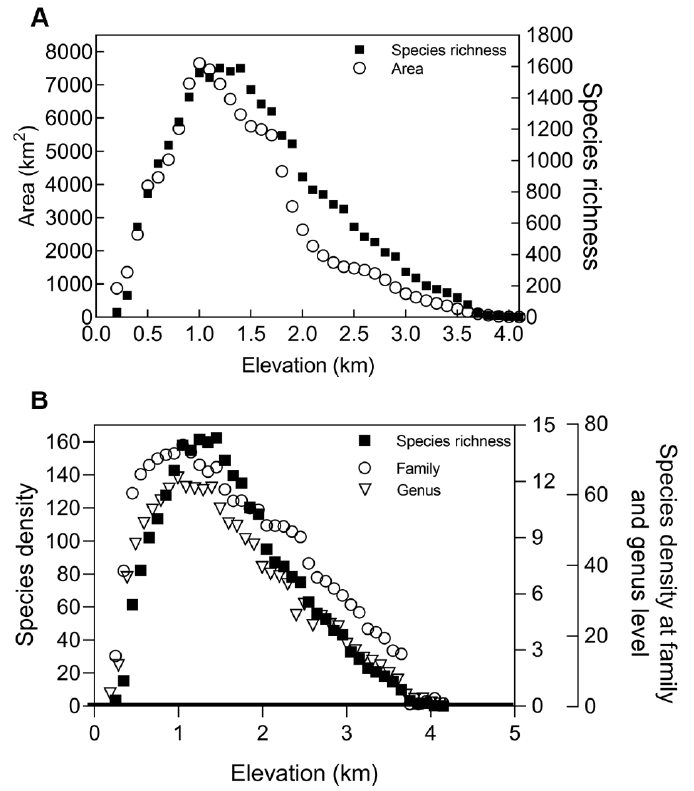
Figure 3. ( A ) The altitudinal patterns of species richness and area in Qinling Mountains ( B ) The altitudinal patterns of density in Qinling Mountains at species (square), genus (inverted triangle), and family (circle) levels.